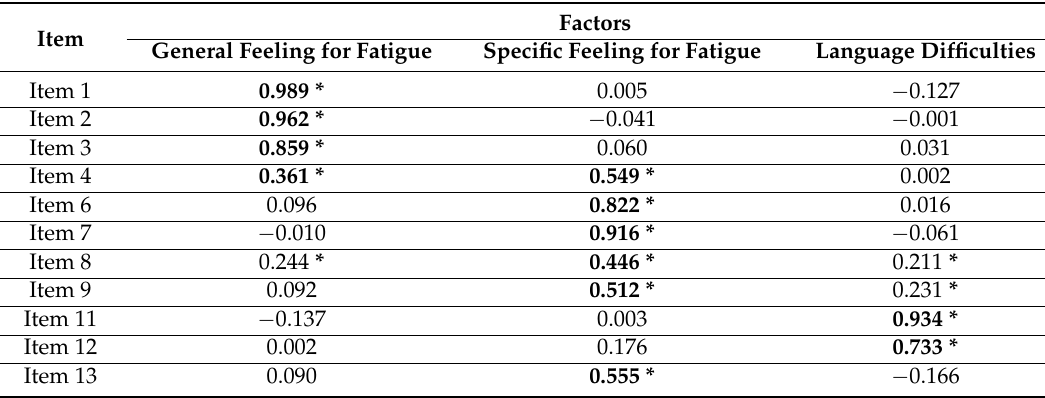
Table 4. Factor loading on the three-factor ESEM models of the